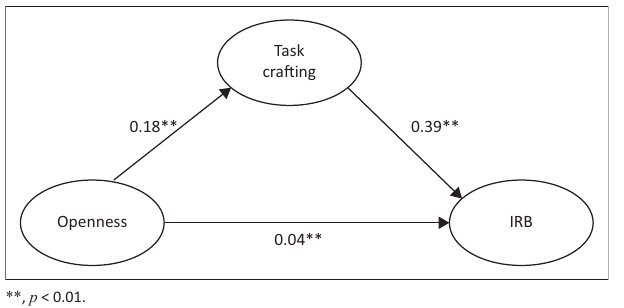
FIGURE 5: Path diagram between openness, task crafting and in-role behaviour.